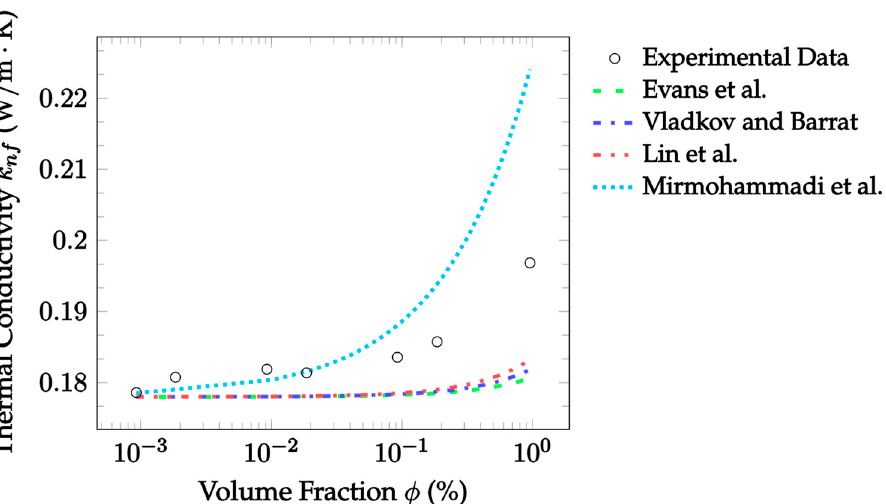
Figure 11. Molecular dynamics simulation predictions compared with experimental data for TiO 2 in ethanol for T = 300 K, volume fractions between 9.09 × 10 − 4 and 0.957%: Experimental data [78], Evans et al. [33], Vladkov and Barrat [34], Lin et al. [35], Mirmohammadi et al. [36].